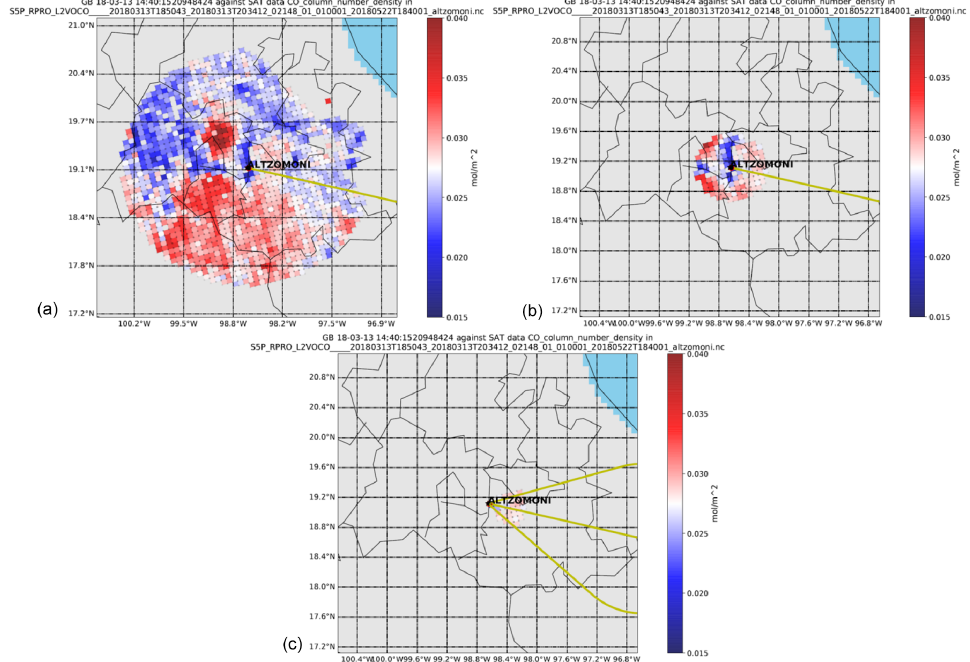
Figure 25. S5P CO column number density plotted around NDACC station at Altzomoni for one sample day. Panel (a) shows all available S5P pixels containing CO data in the overpass file. Panel (b) shows the co-located S5P pixels with 50km radius selection criterion. Panel (c) shows the co-located S5P pixels with the cone co-location criterion with 1 ◦ opening angle of the cone at the highest altitude. The yellow line in the plots represents the line of sight of the ground-based FTIR at the time of the satellite overpass over the